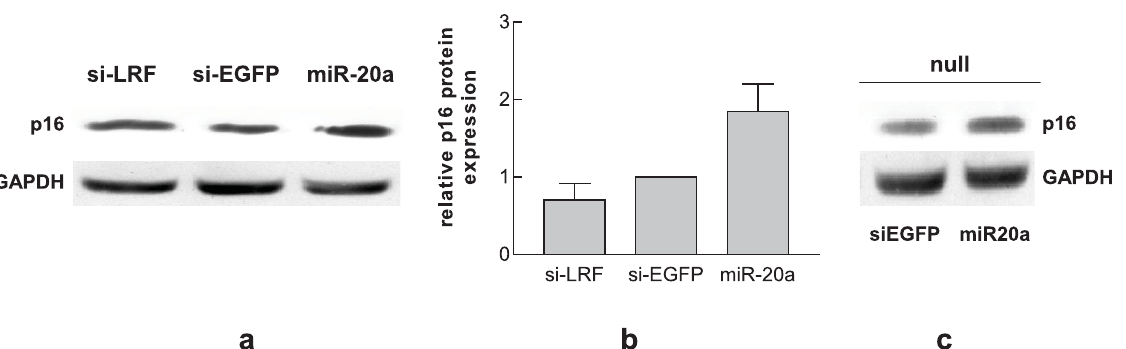
Figure 5. miR-20a regulates p16. Western blot analysis showing the expression of p16 after miR-20a transfection in wt MEF (a,b) and in LRF-null MEF (c) . Each bar represents the mean 6 SE of three independent experiments.